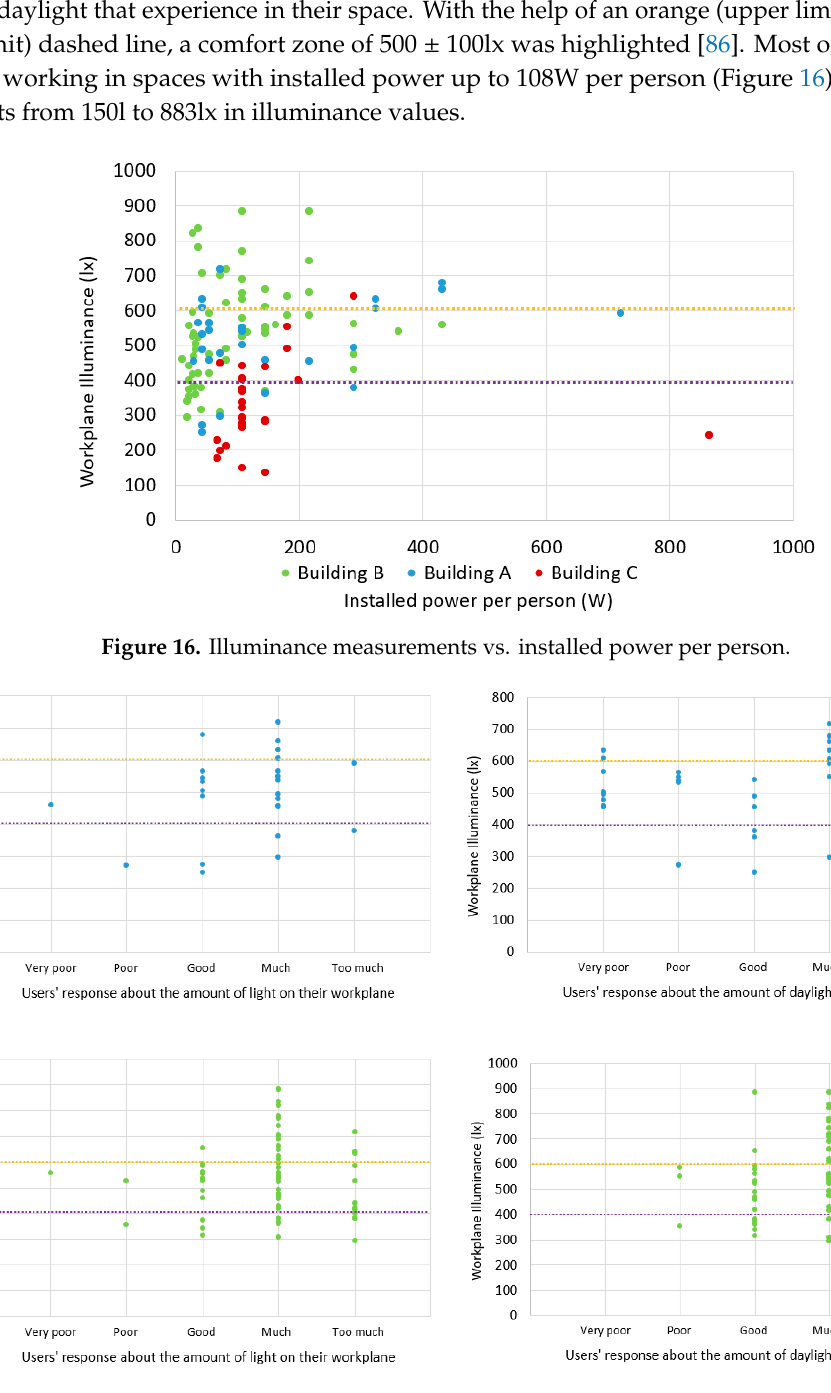
Figure 15. Preference of occupants for the occupants’ control on the amount of daylight that impinges on their working plane.